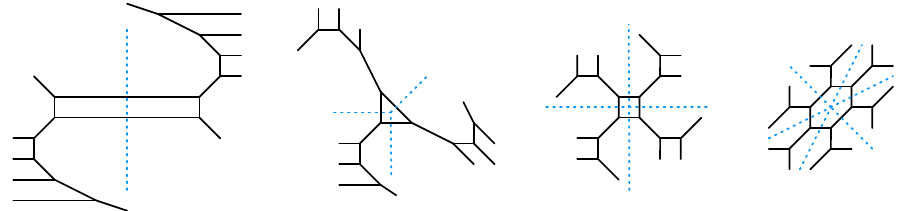
Figure 6 . 5-brane webs for SU(2) + 8 F explicitly revealing Z 2 , Z 3 , Z 4 , Z 6 discrete symmetries (from the left to the